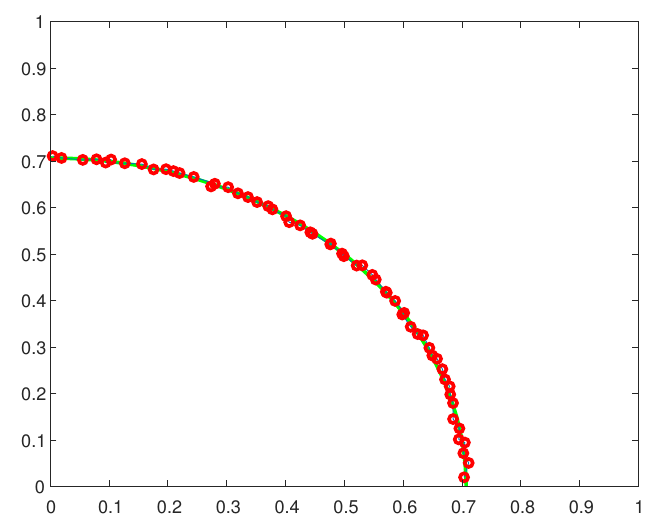
Figure 13. The singularity curve Γ ∗ (blue) and points of maximal first differences of f 50 .